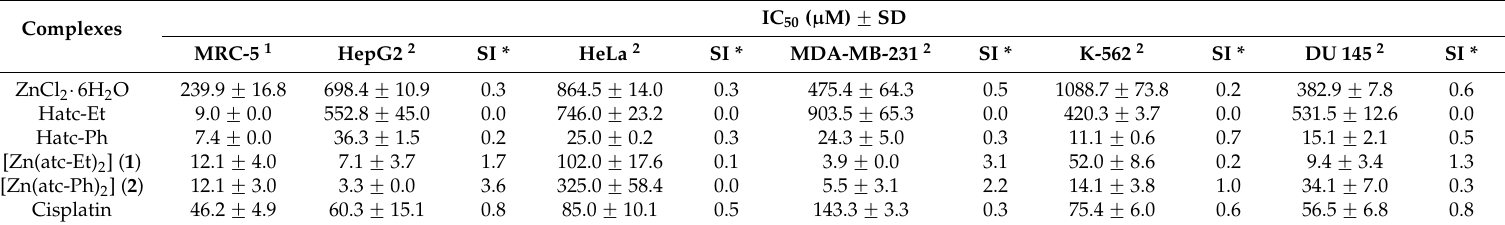
Table 2. Cytotoxicity (IC 50 ) of ZnCl 2 ¨ 6H 2 O, free ligands, complexes 1 and 2 and cisplatin against tumor cell lines and normal (MRC-5) cells.